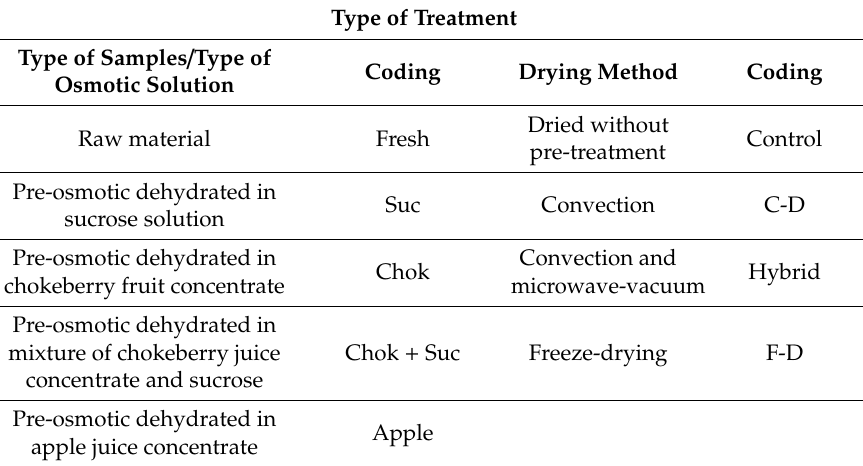
Table 1. Summary of sample